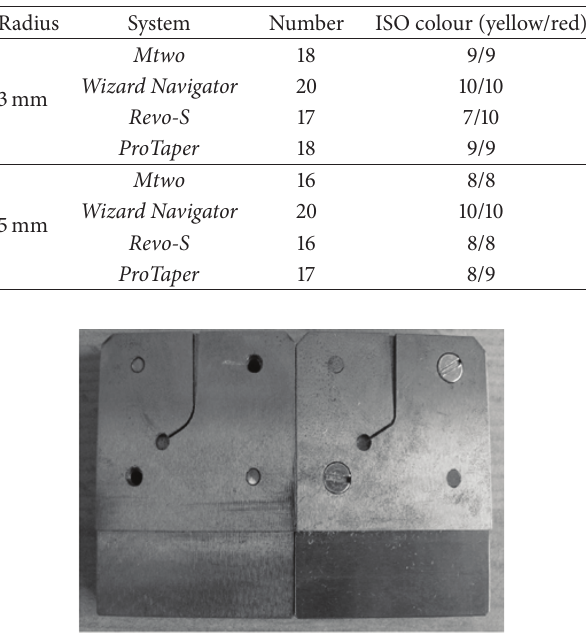
Figure 1: Artificial canals in stainless steel with radii of curvature of 5 mm (left panel) and of 3mm (right